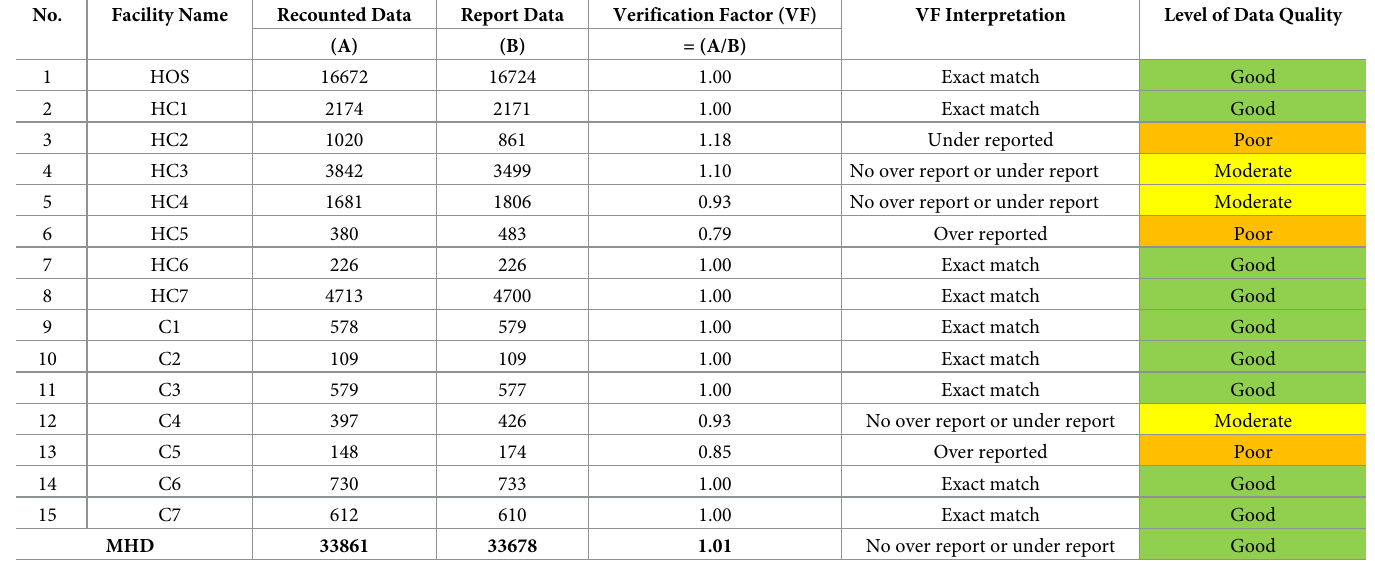
Table 5. Accuracy of reported number of suspected malaria cases tested: Verification factor. No.